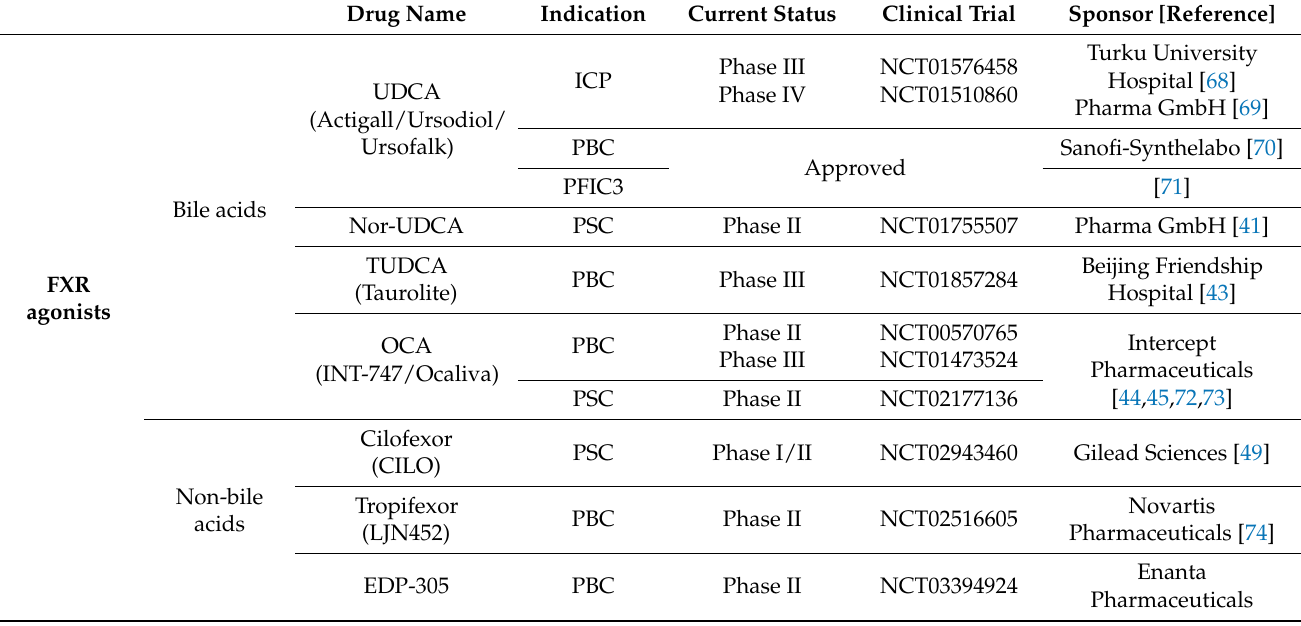
Table 1. Drug therapy for cholestatic diseases in clinical